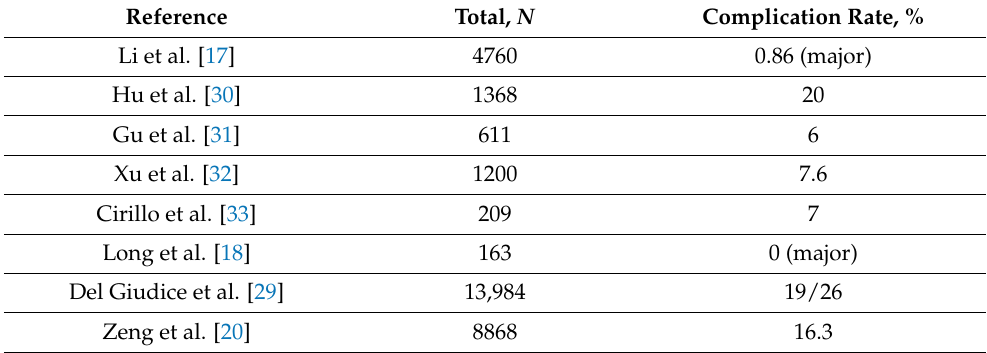
Table 4. Complication